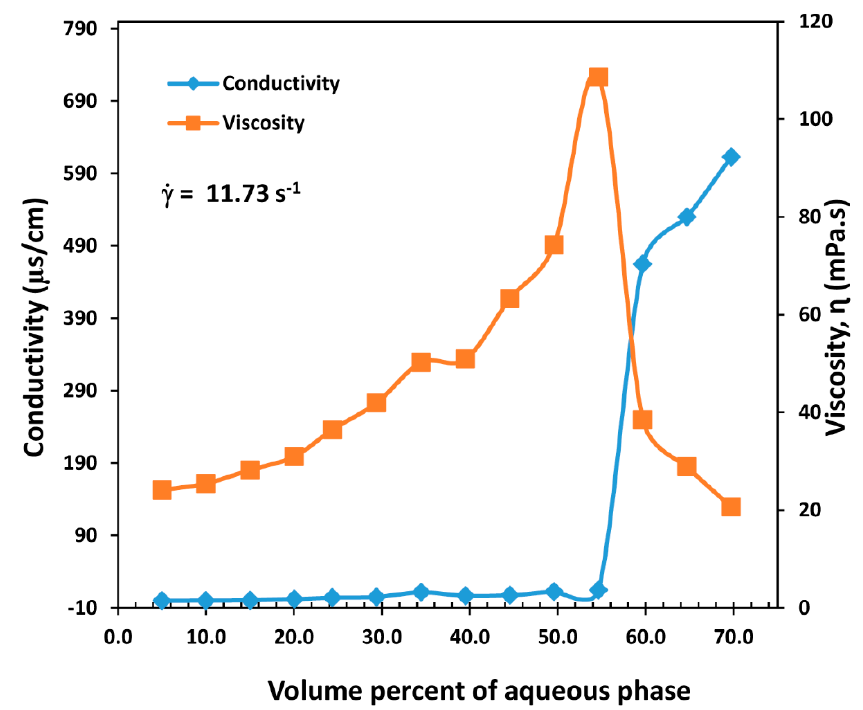
Figure 12. Variations of electrical conductivity and viscosity of emulsion with the increase in aqueous-phase concentration. SNP concentration of aqueous phase is 1% wt.